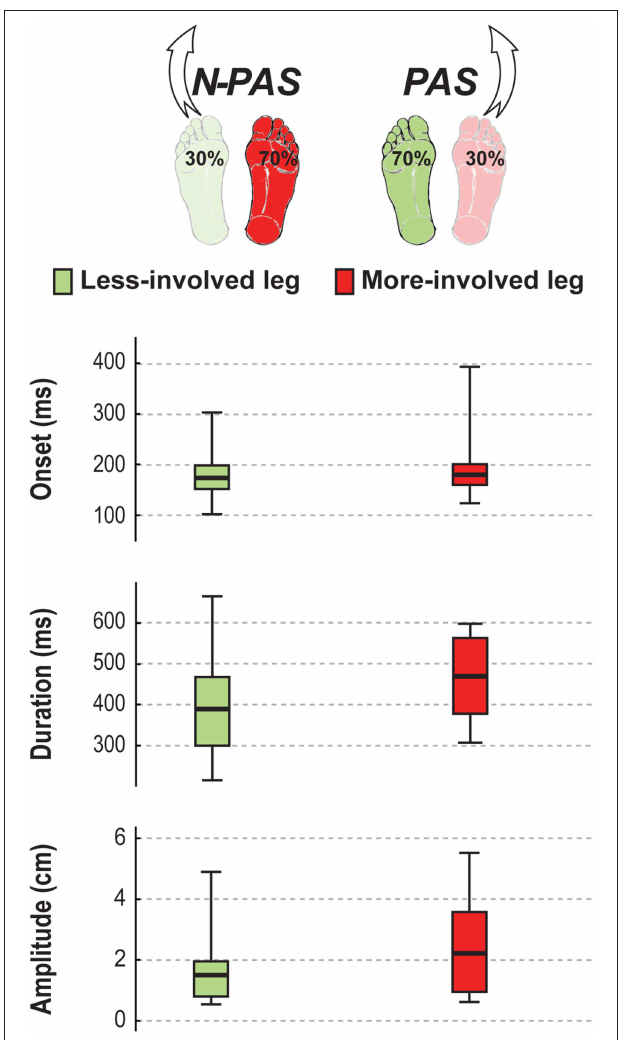
FIGURE 7 | APA characteristics in stroke. The median (thick line) of the anticipatory postural adjustment’s characteristics is presented for the stroke participants when stepping with the less-involved leg in the non-preferred stance condition (N-PAS) and with the more-involved leg in the preferred stance condition (PAS). Boxes represent 25 and 75th percentile. Bars represent min and max